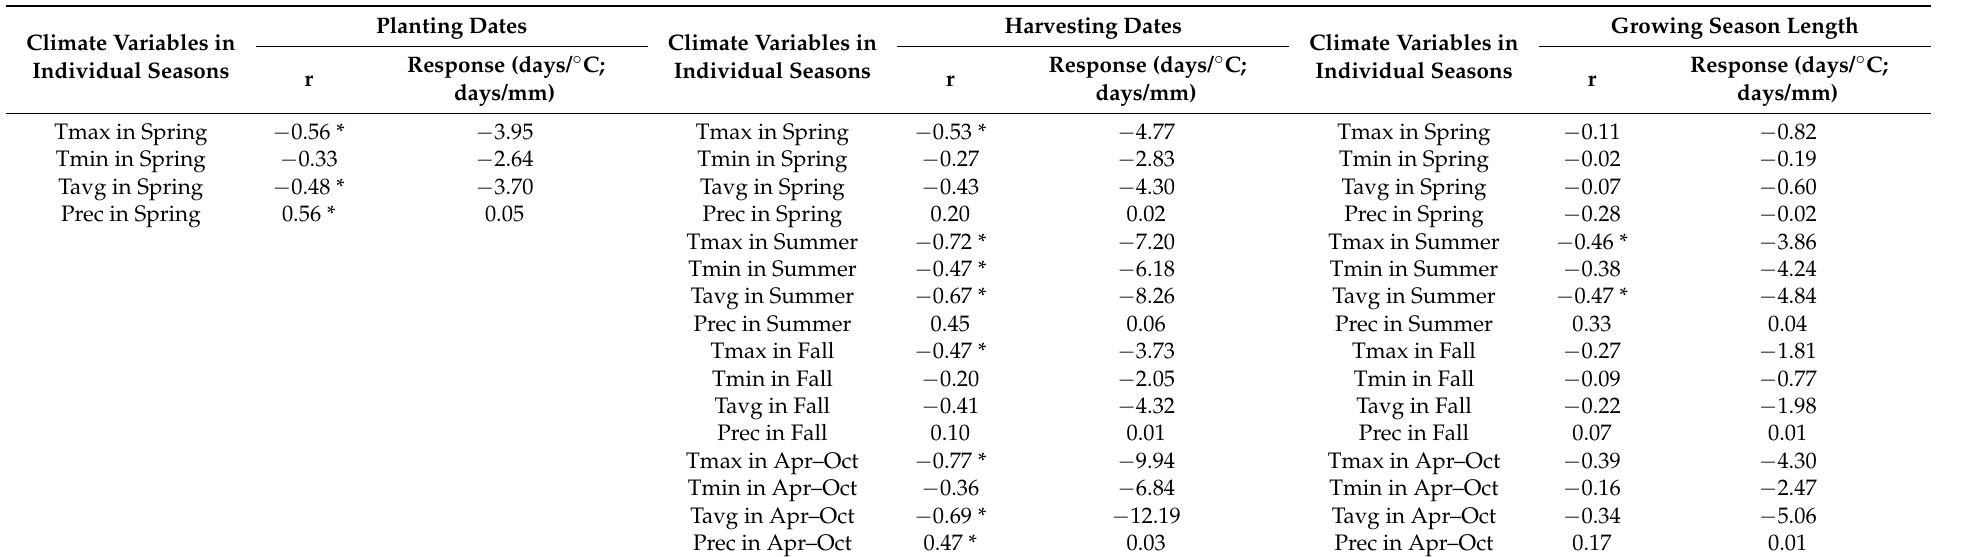
Table 4. Correlations between corn phenology and climatic variables in Kentucky,